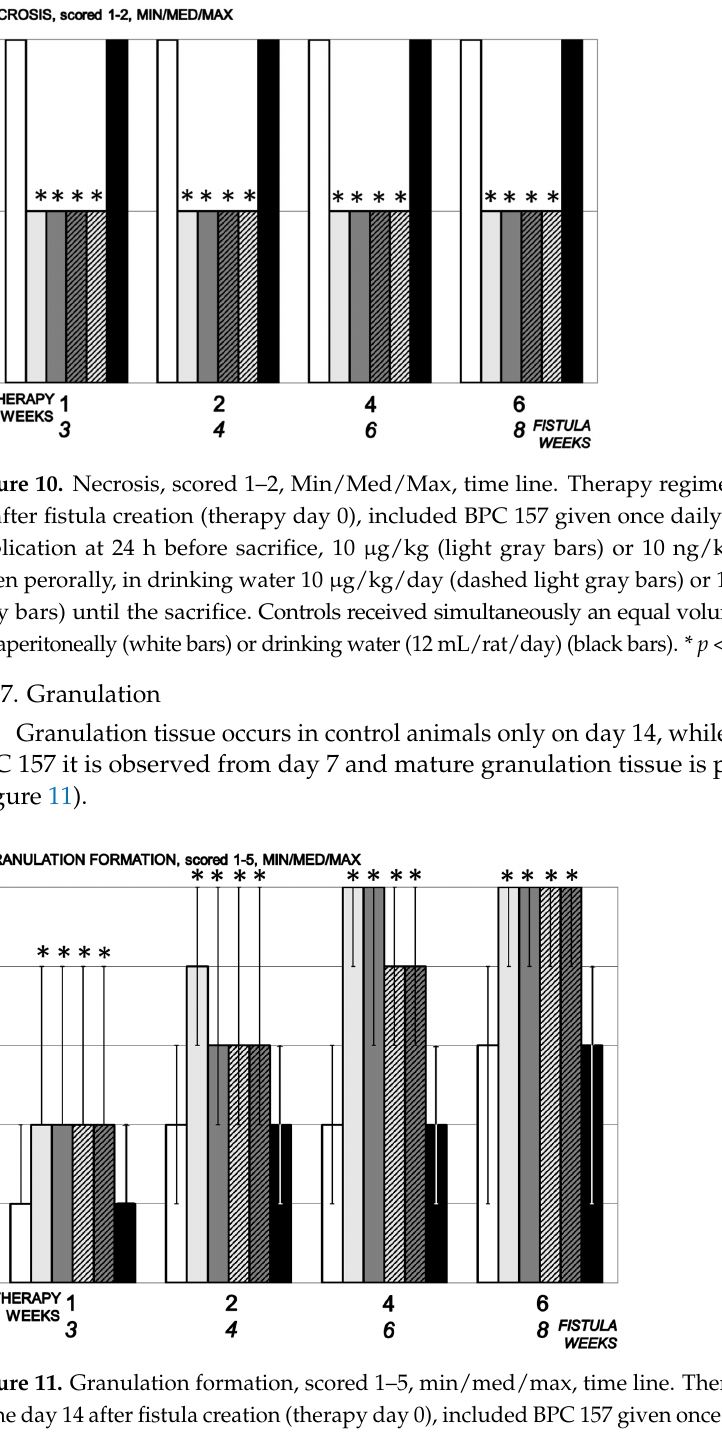
Figure 9. Vascularization, scored 1–4, min/med/max , time line. Therapy regimens starting at the day 14 after fistula creation (therapy day 0), included BPC 157 given once daily intraperitoneally, last application at 24 h before sacrifice, 10 µg/kg (light gray bars) or 10 ng/kg (dark gray bars) or given perorally, in drinking water 10 µg/kg/day (dashed light gray bars) or 10 ng/kg (dashed dark gray bars) until the sacrifice. Controls received simultaneously an equal volume of saline (5 mL/kg) in- traperitoneally (white bars) or drinking water (12 mL/rat/day) (black bars). * p < 0.05, relative to control.